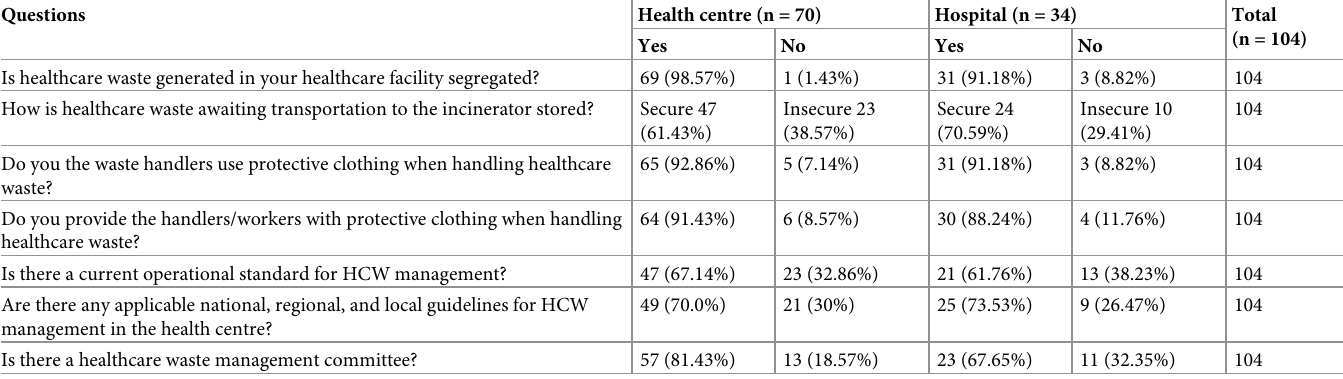
Table 7. Managers response on HCW management in the study health facilities, Addis Ababa City Administration, February 2018.